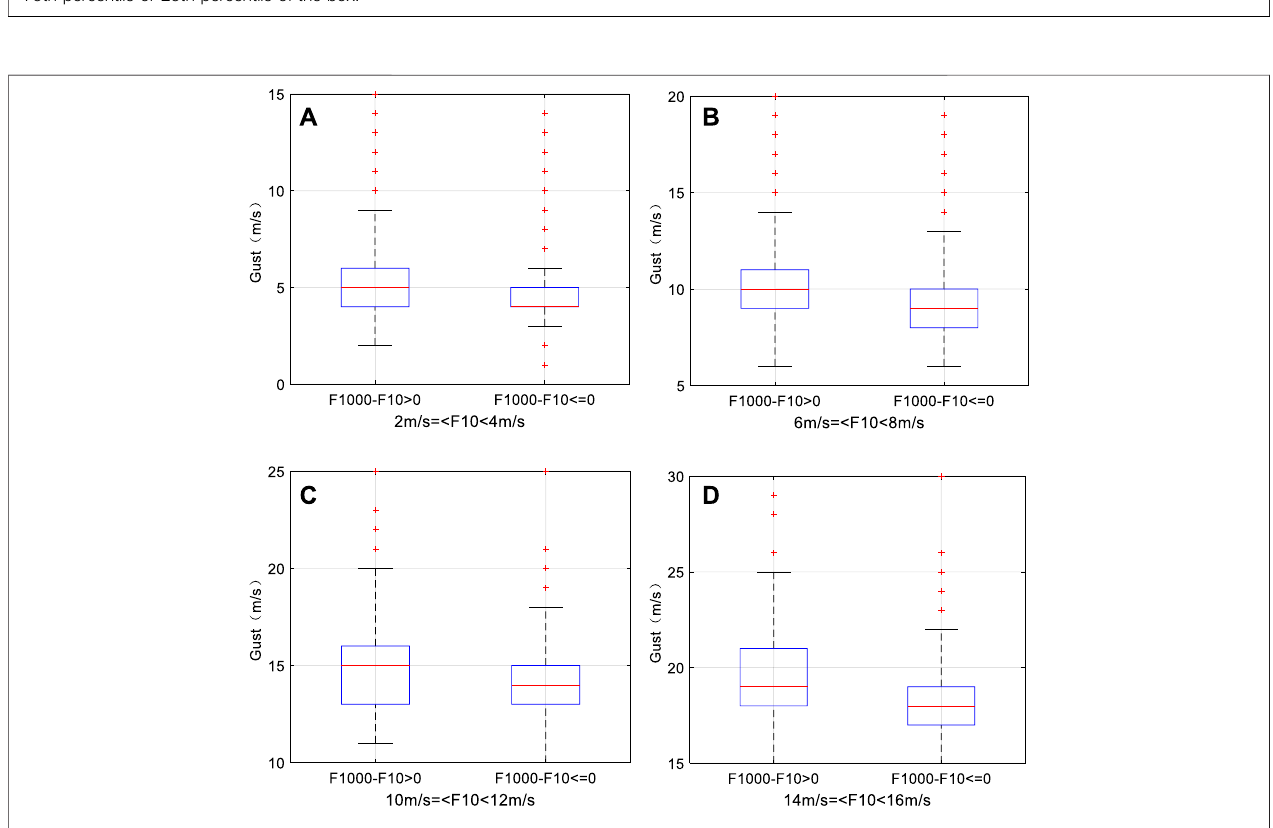
FIGURE 3 | Boxplots of gusts under different average wind speeds when F1000-F10 > 0 and F1000-F10 ≤ 0 from 2017 to 2019: (A) 2 m/s ≤ F10 < 4 m/s; (B) 2 m/s ≤ F10 < 4 m/s; (C) 2 m/s ≤ F10 < 4 m/s; and (D) 2 m/s ≤ F10 < 4 m/s.